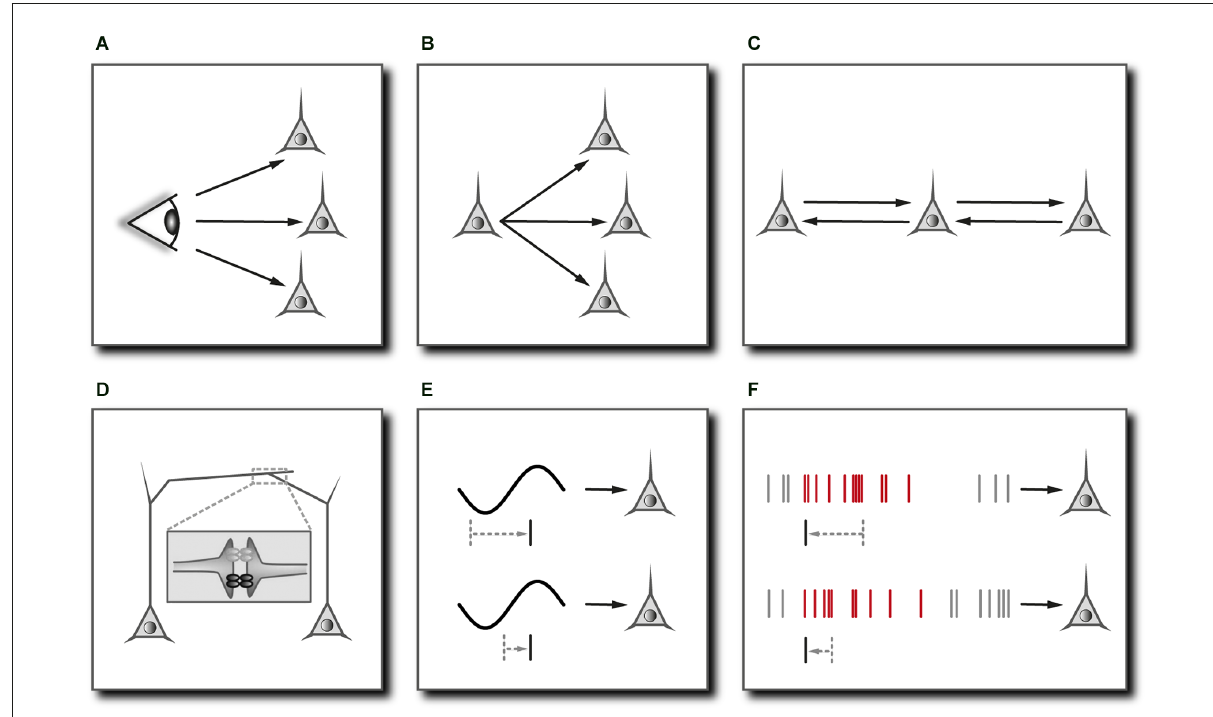
FIGURE2 Mechanisms mediating neuronal synchronization in cortical networks. (A) Common sensory input. In principle, neurons may fire synchronously simply because they are driven by a common sensory stimulus. In cortical areas, however, sensory signals are modulated by the ongoing activity and follow a multitude of diverging and converging pathways with differing delays, rendering neuronal synchrony non-trivial. Prerequisite: Adaptations of the functional network to bring about synchronous groups of neurons depending on stimulus features. May require (F) . (B) Common input from the same presynaptic neuron. Prerequisite: Isochronous synaptic connections. (C) Dynamical relaying. Two cells/populations of cells can become synchronized with zero phase lag if coupled reciprocally to a third cell/population of cells. Prerequisite: Relay cell/population of cells occupies a temporally equidistant location from the neurons to be synchronized. Comes down to (B) . (D) Electrical coupling through gap junctions. Reciprocal transmission of graded potentials facilitates the synchronization of coupled cells especially through the formation of multi-cell syncytia, even if the impact of one cell onto another is relatively weak. Reproduced in part from Stephan et al. (2021). (E) Network oscillations. Subthreshold membrane potential oscillations restrict effective excitation to the depolarizing phase of the oscillation cycle and may synchronize coherently oscillating cells by actively controlling the phase of their spiking. Prerequisite: Slow oscillatory input with a relatively long period compared to the membrane time constant and tonic excitatory drive. (F) Synchrony through synaptic plasticity. Neurons that are excited by a repeated sequence of synaptic inputs (marked in red) may learn to selectively respond to the onset of this sequence through synaptic plasticity. Multiple neurons receiving coherent (not necessarily identical) input could thus actively synchronize their firing by learning to selectively respond at corresponding temporal positions. Prerequisite: Effective spike-timing-dependent synaptic